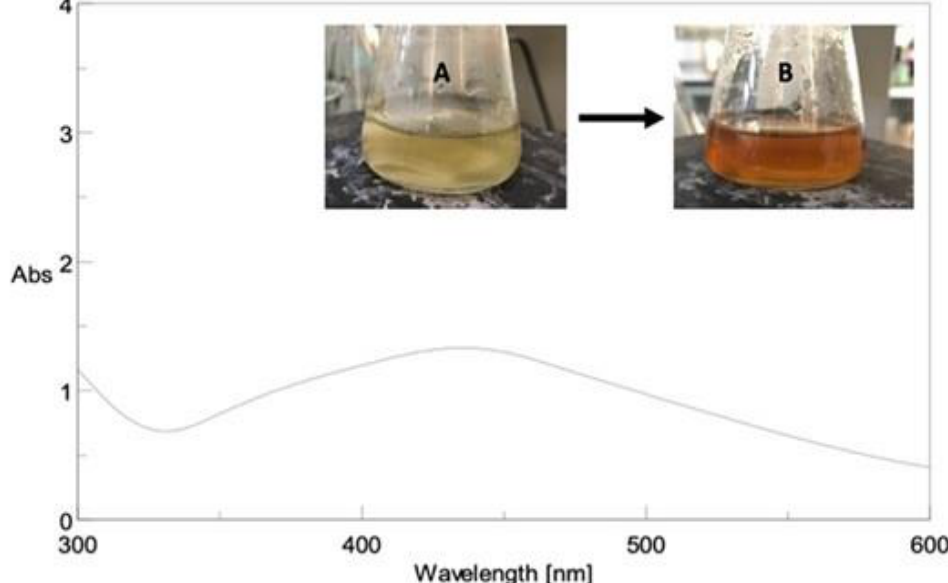
Figure 2. ( A ) The UV-visible spectrum of prepared AgNPs from the phenolic extract of flower part ethanolic extract; ( B ) AgNPs.